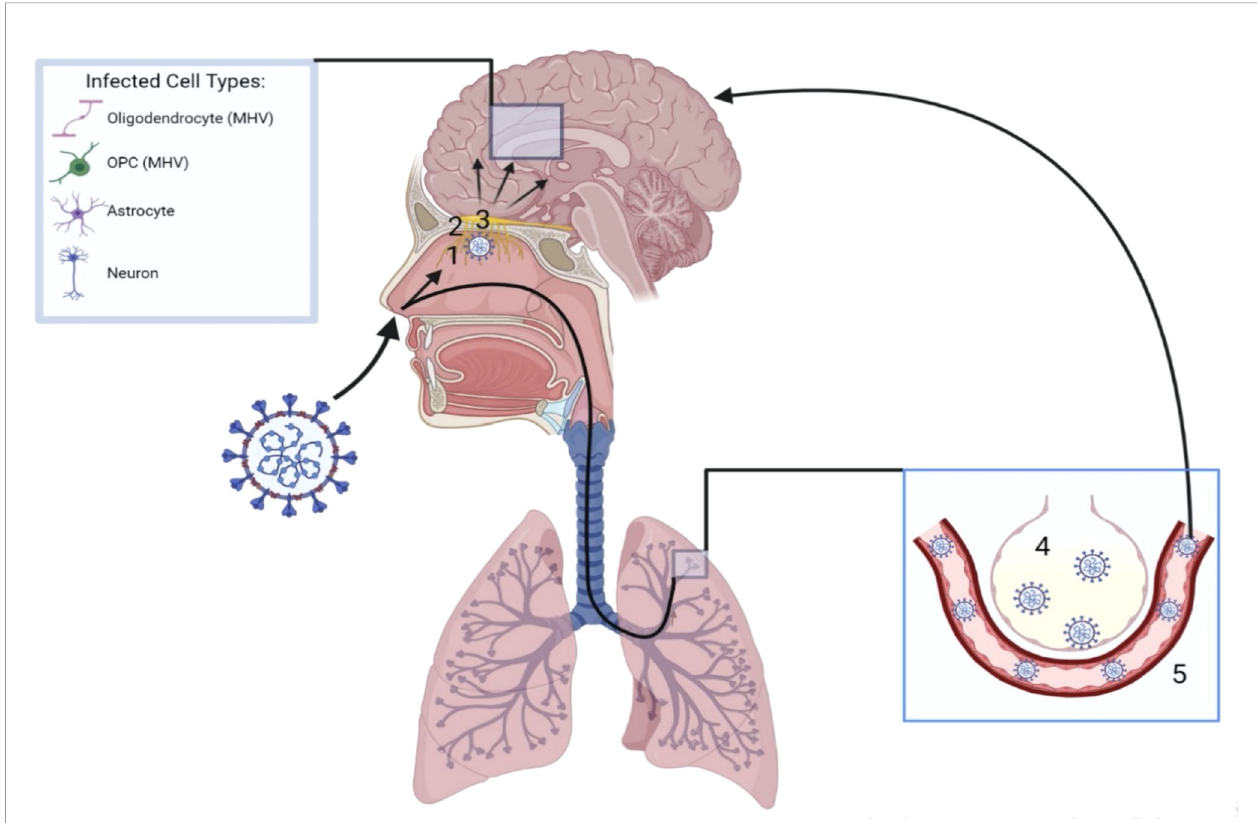
FIGURE 1 | Neurotropism of SARS-CoV-2. Upon inhalation, SARS-CoV-2 can reach the brain parenchyma via two mechanisms. Following the olfactory route, SARS-CoV-2 infects the olfactory epithelium (1) directly under the cribiform plate (2). The virus can then traverse the cribiform plate through its foramina or via the olfactory nerves, gaining access to the olfactory bulb (3) and spreading to fi rst and second order connections throughout the brain. Additionally, SARS-CoV-2 may be inhaled into the lungs, reach the alveoli (4) and gain access into the blood stream (5). A hematogenous route of SARS-CoV-2 neuroinvasion can then occur following breach of the BBB. Once inside the brain parenchyma, neurons and glial cells such as astrocytes have been shown to be directly infected. Oligodendrocytes and OPCs have shown similar infection with the coronavirus strain